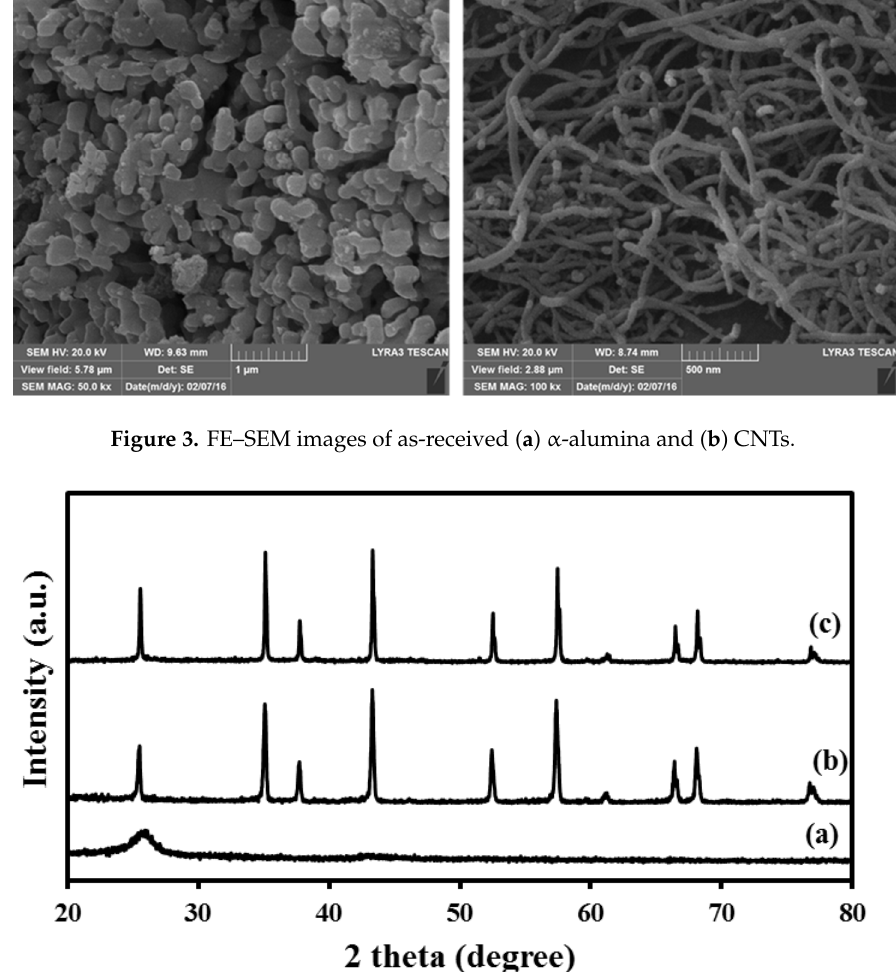
Figure 3. FE–SEM images of as-received ( a ) α -alumina and ( b ) CNTs.